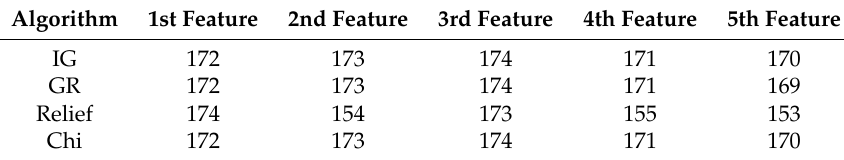
Table 1. Top five important features using implemented feature selection